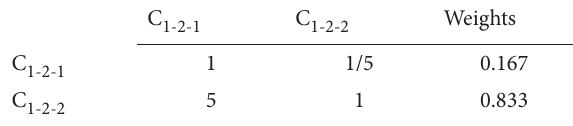
Table 6. Pairwise comparison matrix for Accident related factors and their weights